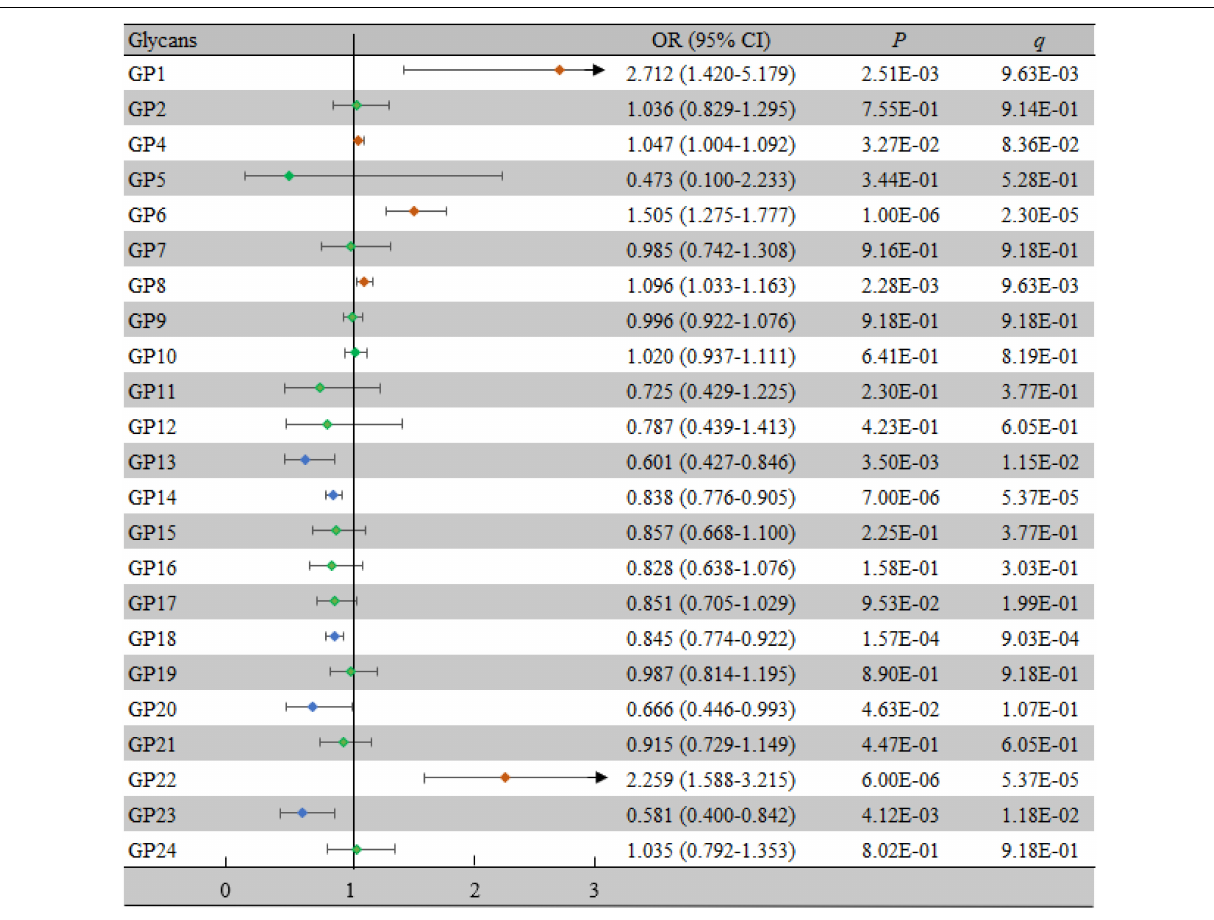
q < 0.001) were significantly associated with VCI after adjusting for confounding factors ( Figure 1